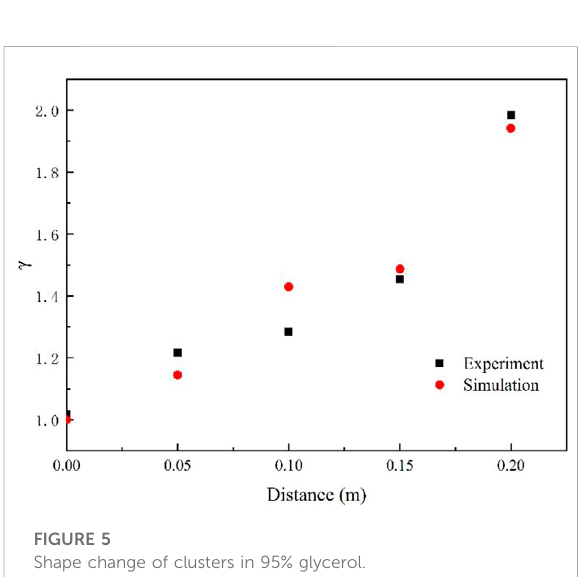
FIGURE 5 Shape change of clusters in 95%